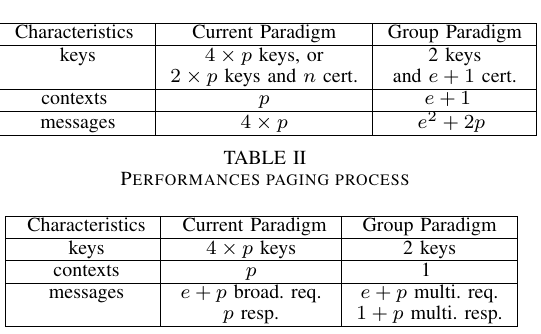
TABLE I P ERFORMANCES DURING A CONNECTION